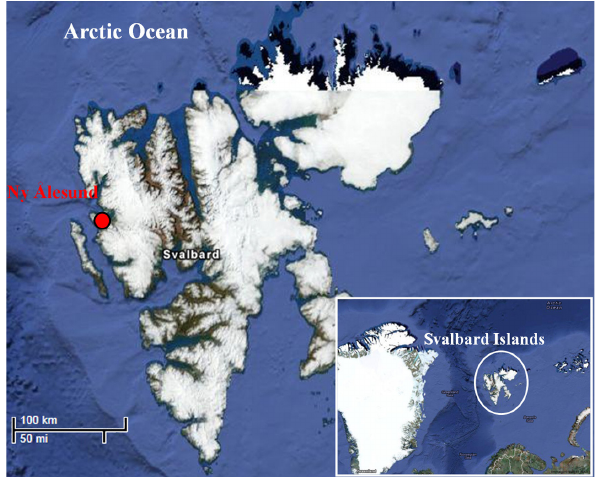
Fig. 1. Sampling location of Arctic aerosols at Ny- ˚ Alesund, Sval- bard